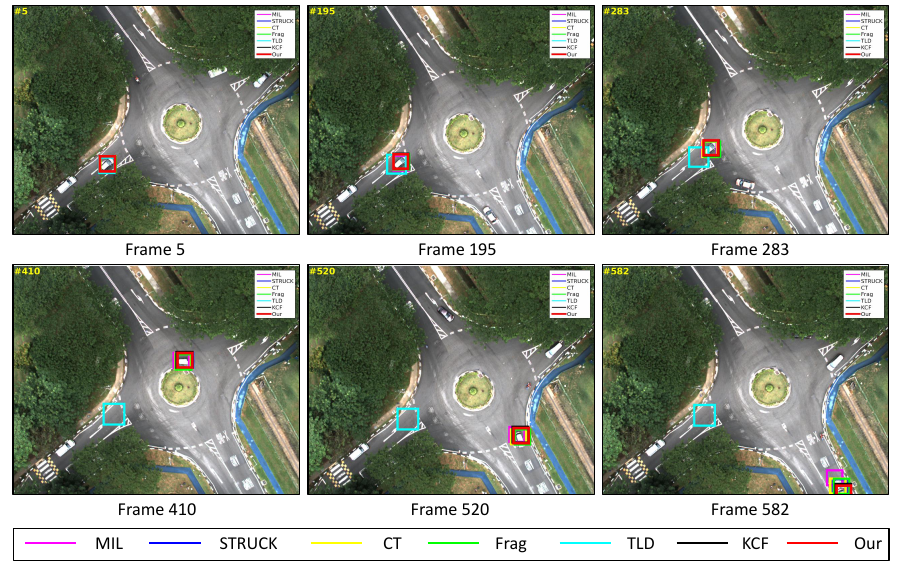
Figure 20. Some tracking results in the moving car image sequence. The total number of frames: